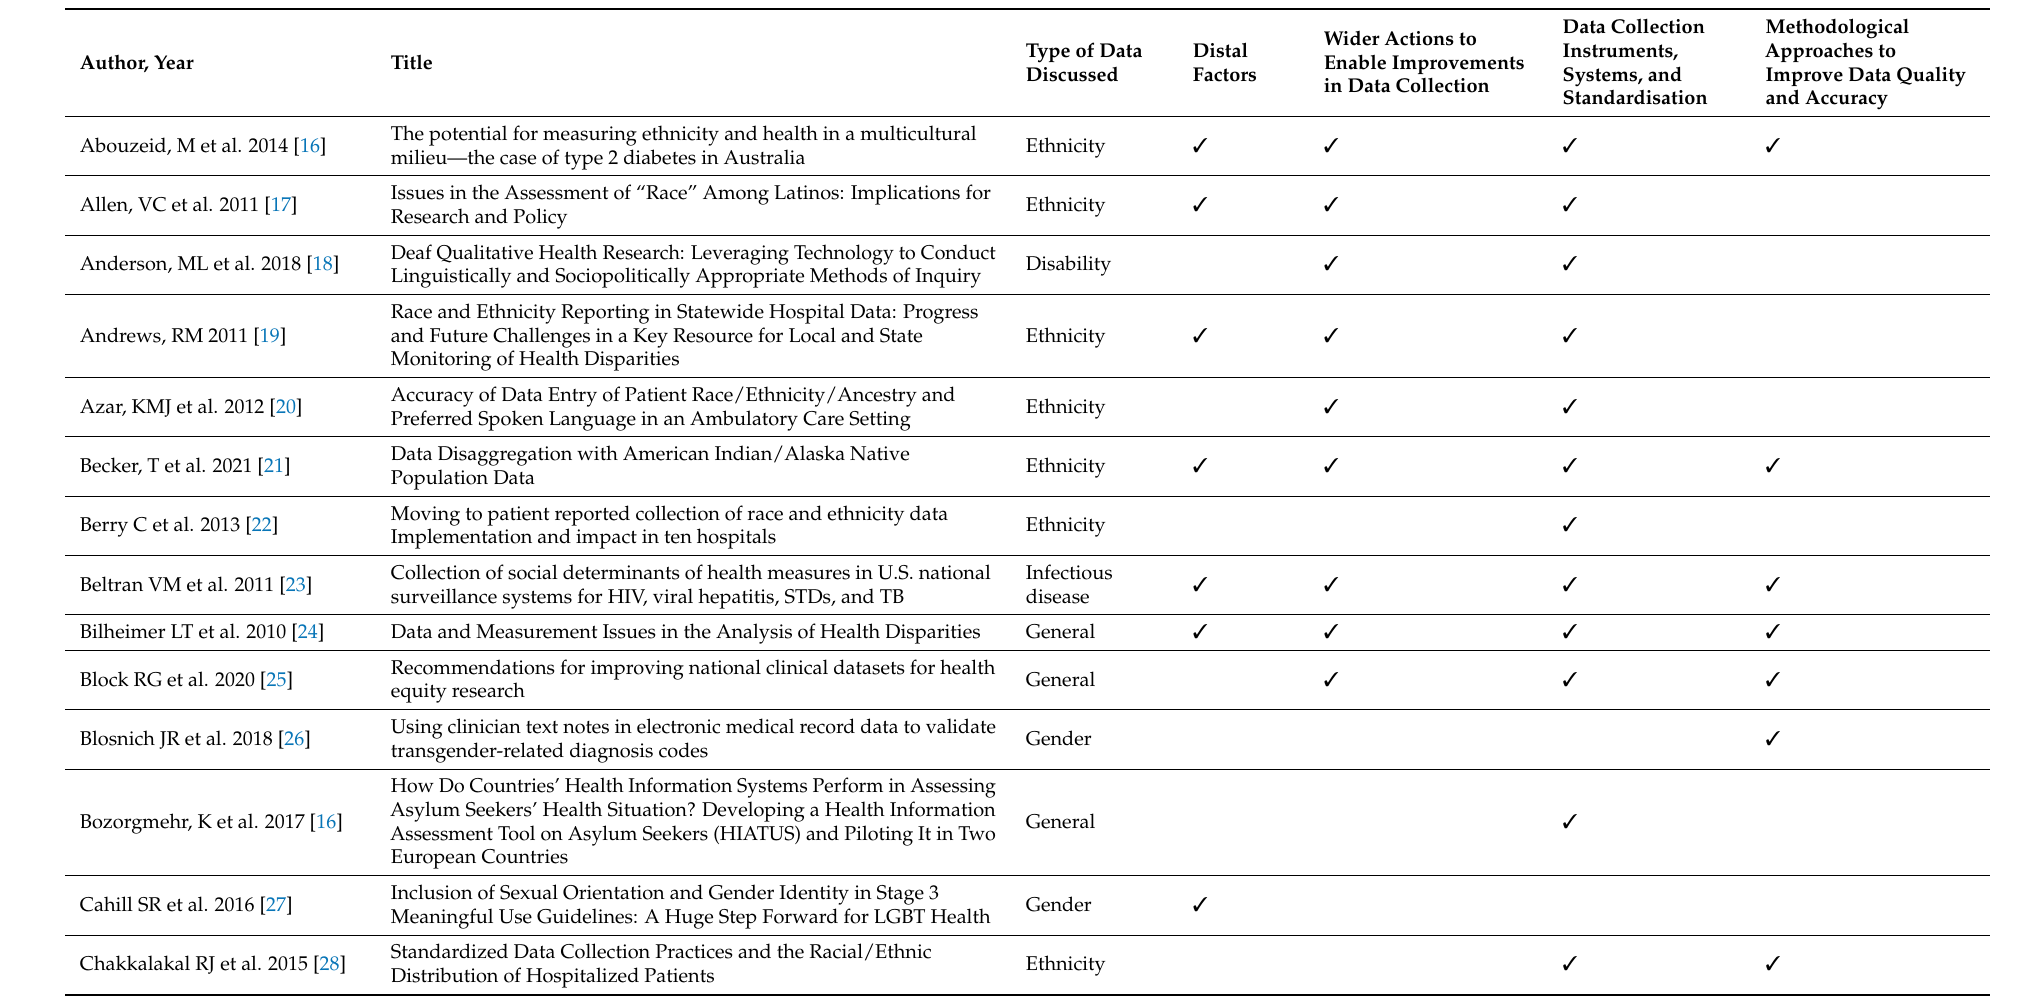
Table 1. Included studies and